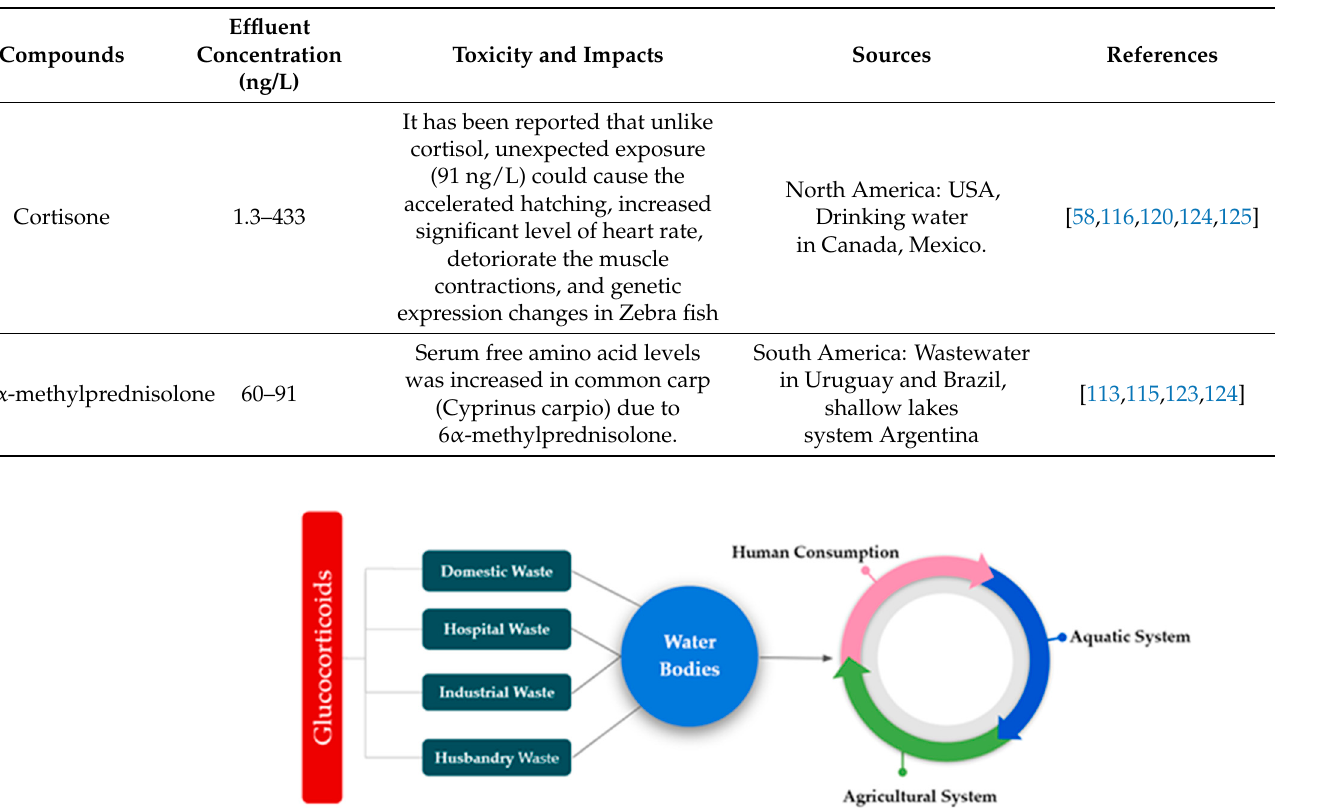
Figure 1 . Fate of glucocorticoids (GCs) in different sectors of the environment